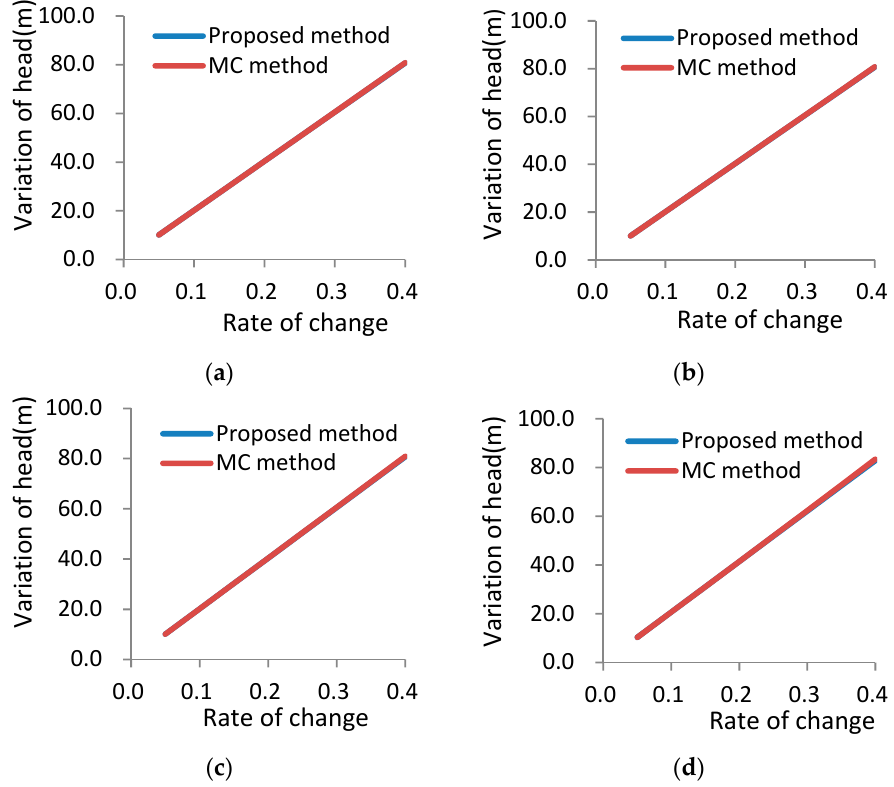
Figure 4. Comparison of two methods in Scenario Three (( a ) observation well 2; ( b ) observation well 3; ( c ) observation well 4; ( d ) observation well 5). Table 6. Calculation results table for Scenario Three (unit: m).